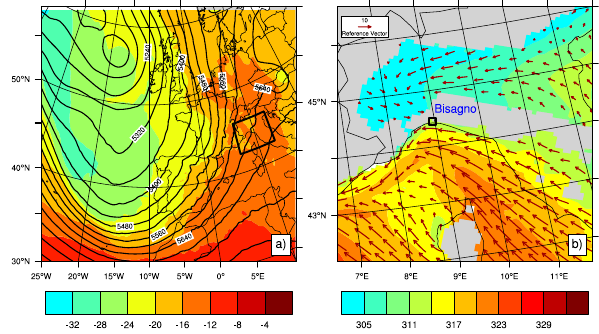
Figure 2. ECMWF large-scale analysis at 00:00UTC on 4 Novem- ber 2011 showing (a) temperature ( ◦ C) and geopotential height (m) at 500hPa and (b) equivalent potential temperature (K) and winds (ms − 1 ) at 950hPa. The black rectangle on (a) represents the inter- ested region (plotted in b ), covering Liguria in north-western Italy. The shaded areas represent orographic regions. The position of the Bisagno water basin is included for reference on (b)